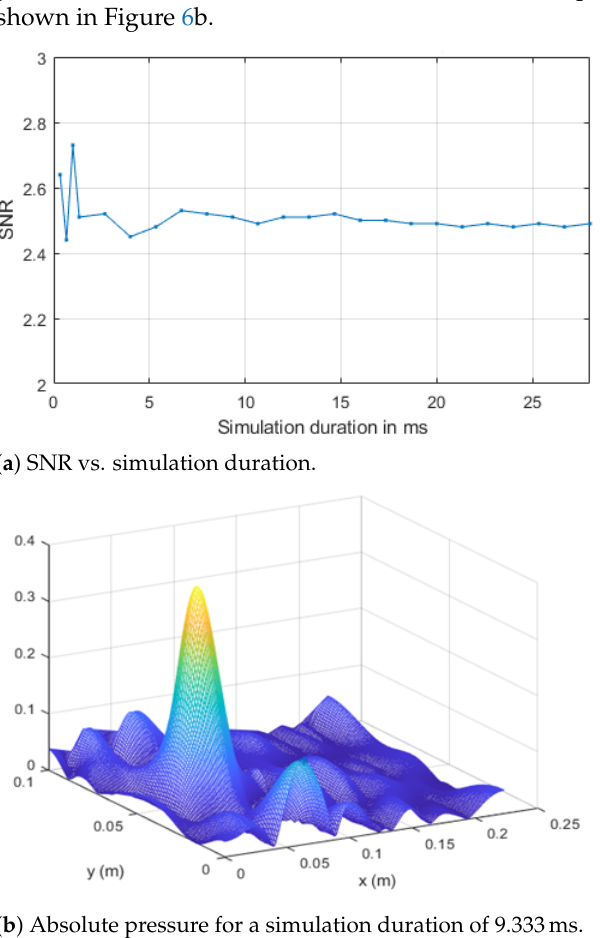
Figure 6. The SNR vs simulation duration when all emitters on the beams are active (corresponding to the last row of Table